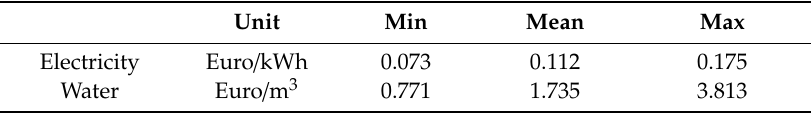
Table 4. Prices of electricity and water used in this work.